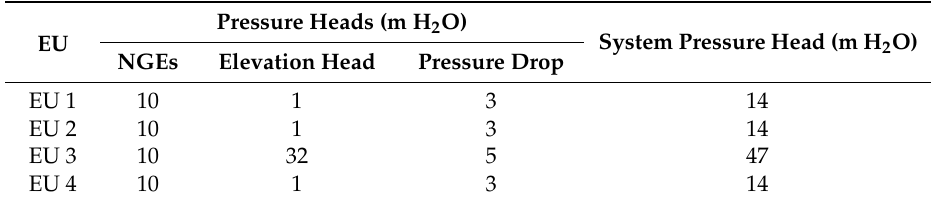
Table 3. System pressure head required by the irrigation system in each EU, and their contributions from the new-generation emitters (NGEs), the elevation head, and the pressure drop.